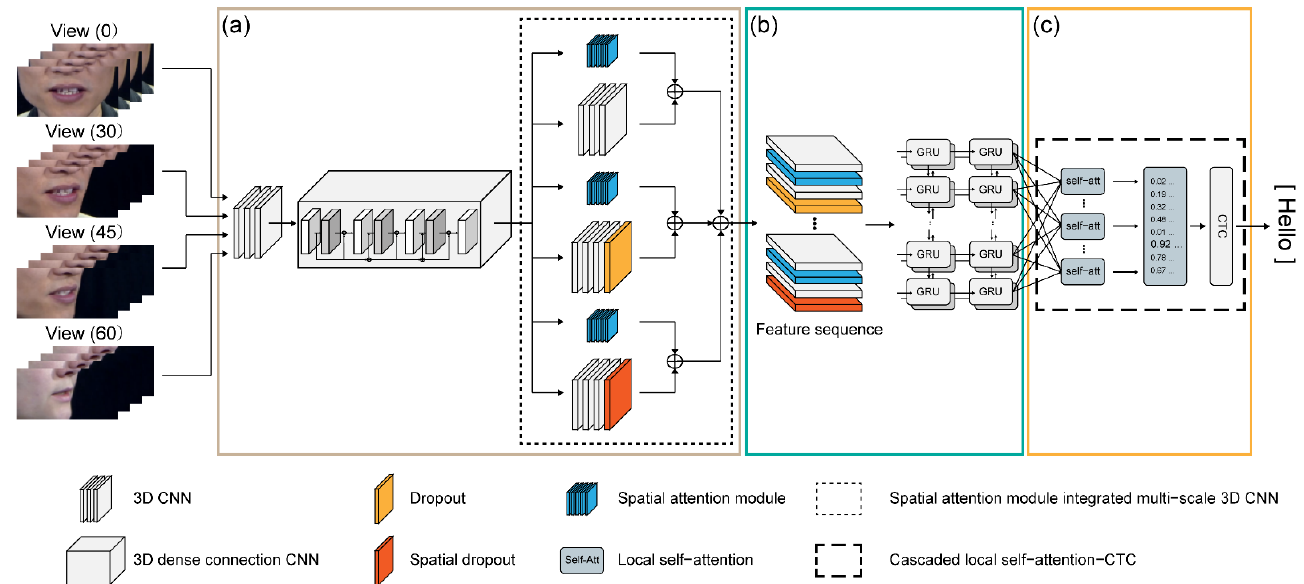
Figure 1. Block diagram of the proposed multi-view lipreading architecture; ( a ) convolutional layer; ( b ) recurrent layer; and ( c ) transcription layer.